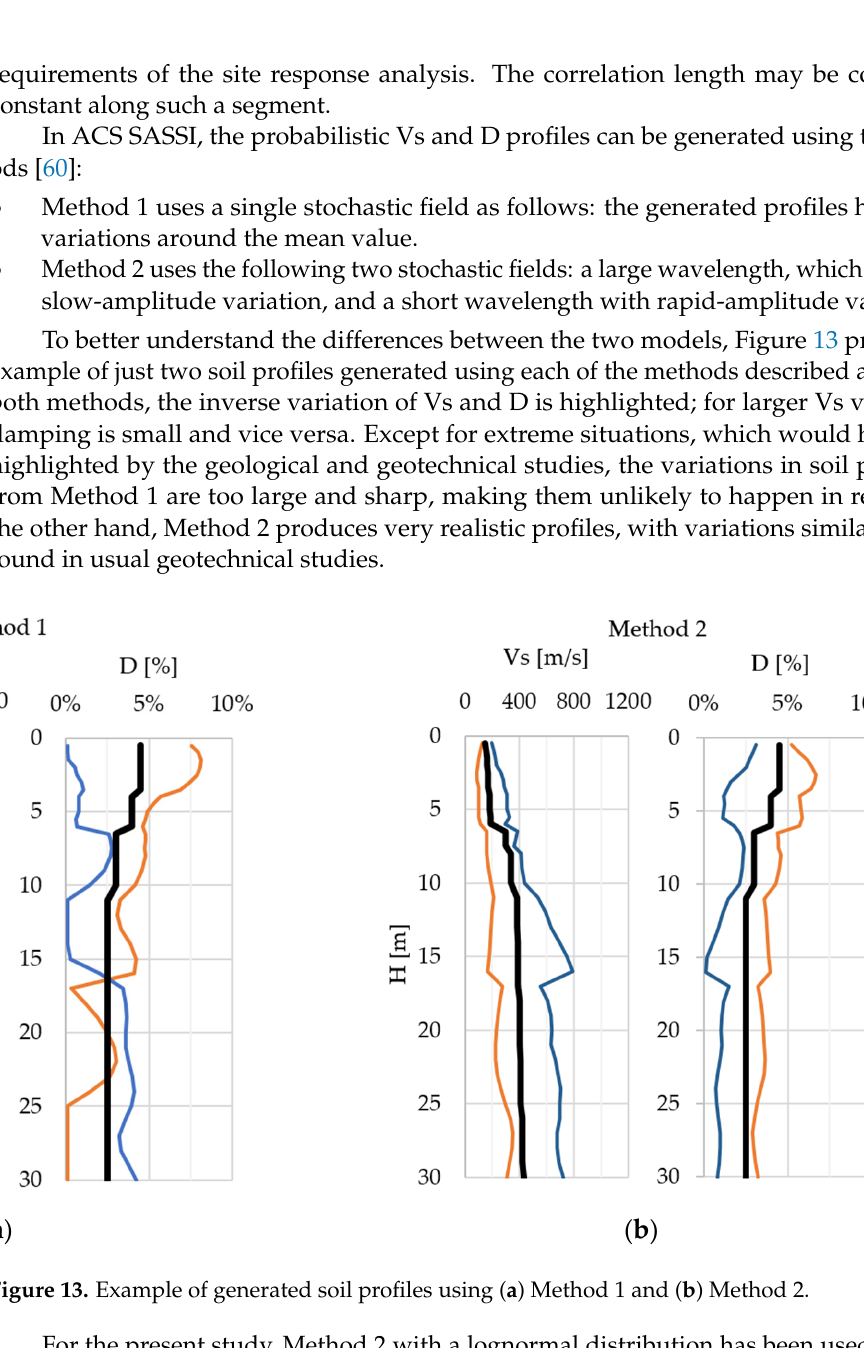
Table 2. Probabilistic Vs and D profile generation parameters [49]. Short Wave-Length